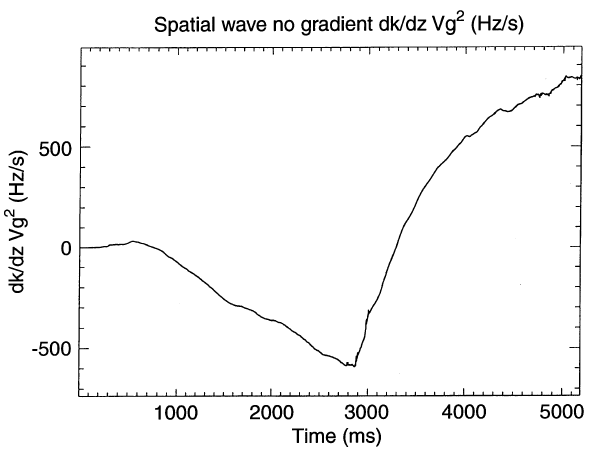
Fig. 22. Case D. Plot of spatial gradient of wave number as a function of time. The value falls to ) 500 Hz/s in the faller segment and then switches to +800 Hz/s in the subsequent riser segment